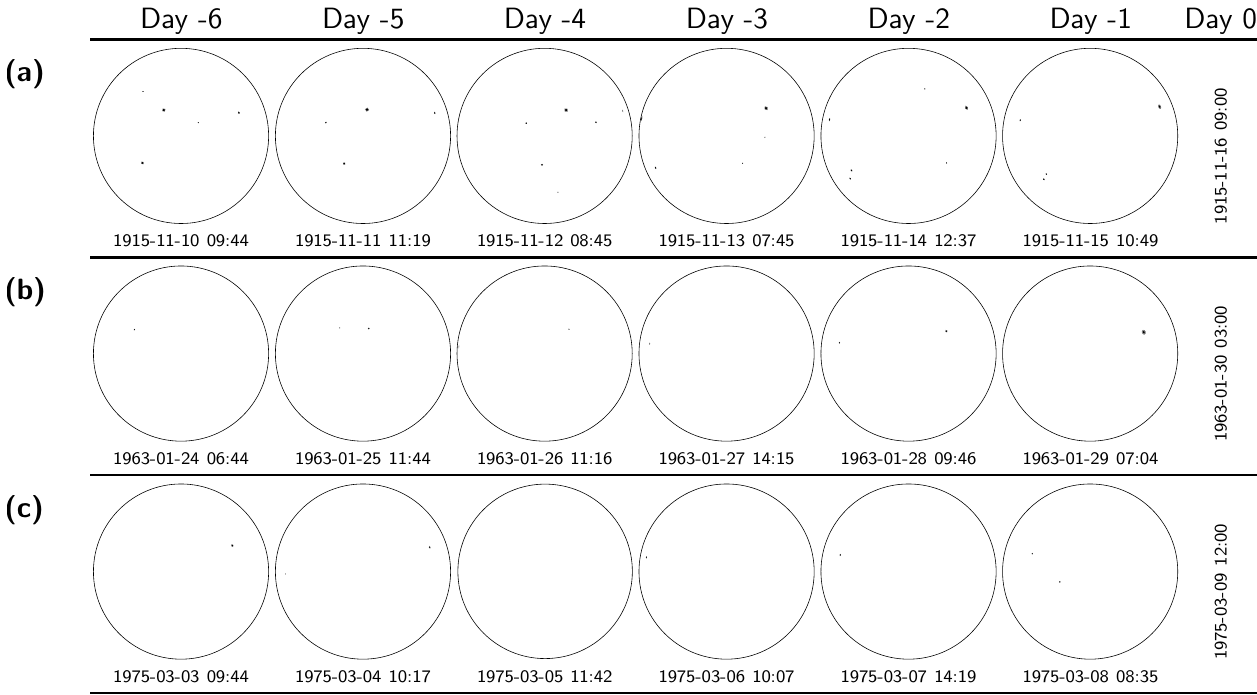
Fig. 2. Reconstructed solar images for the six-day intervals immediately before the major geomagnetic storms that commenced on: (a) 1915 November 16; (b) 1963 January 30; and (c) 1975 March 9. No sunspots were present on the solar disk on 1975 March 5 (and hence no information is stored in the sunspot digital dataset for this particular